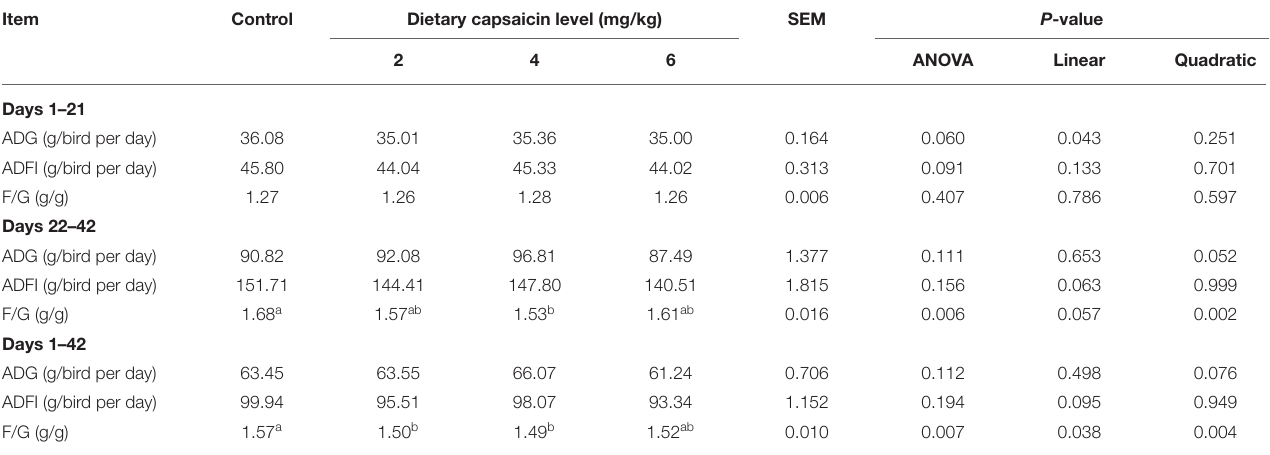
TABLE 2 | Effects of different levels of capsaicin on the growth performance of broilers. Item